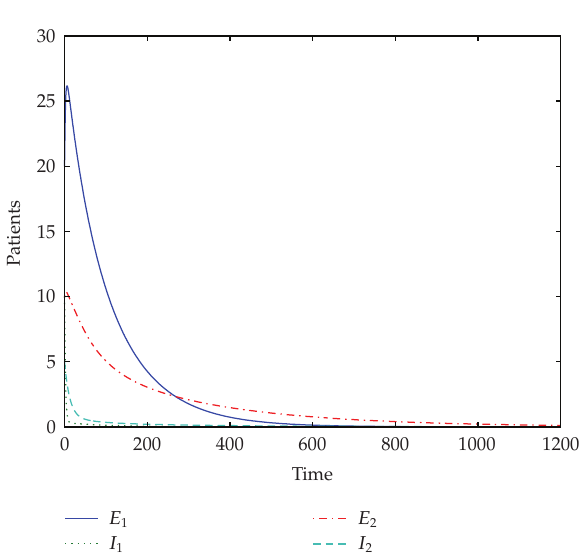
Figure 11: Trajectories of system (cid:2) 2.2 (cid:3) when β 1 (cid:2) N (cid:3) (cid:8) β 1 C (cid:2) N (cid:3) , β 2 (cid:2) N (cid:3) (cid:8) β 2 C (cid:2) N (cid:3) , C (cid:2) N (cid:3) (cid:8) N/ (cid:2) 1 (cid:9) N (cid:9) √ 1 (cid:9) 2 N (cid:3) , β 1 (cid:8) β 2 (cid:8) 0 . 001, d 1 (cid:8) 0 . 02, d 2 (cid:8) 0 . 07, so that R 1 < 1, R 2 < 1. It shows that the disease-free equilibrium P 0 is stable.